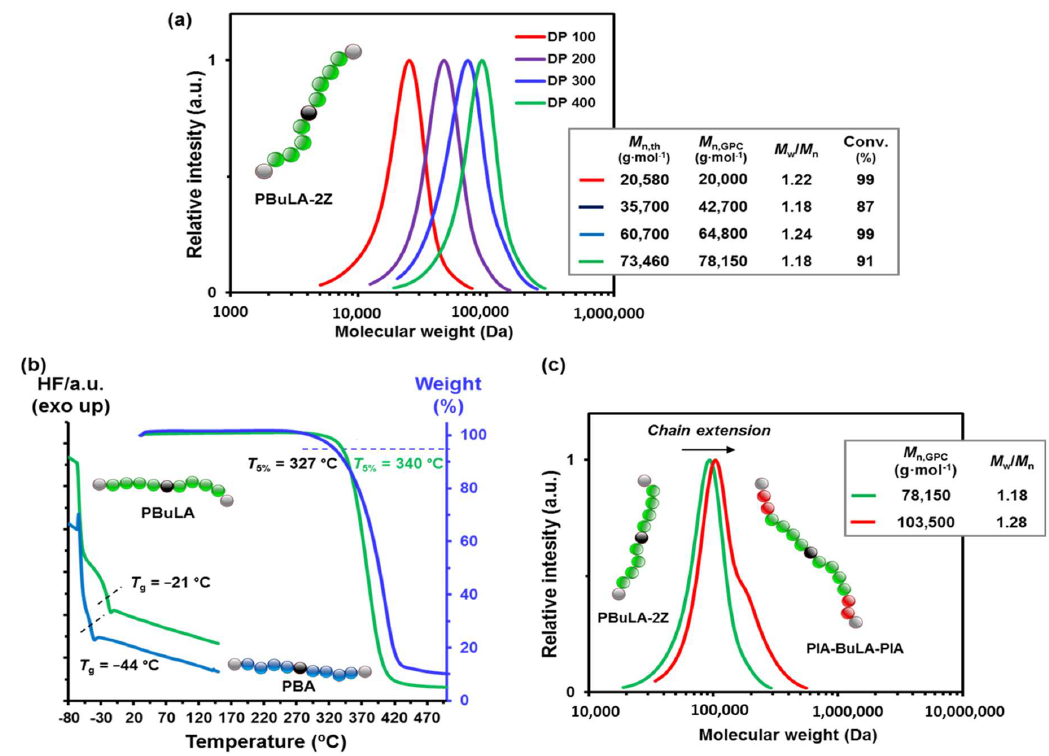
Figure 7. ( a ) Gel permeation chromatography (GPC) traces of PBuLA-2Z prepared at di ff erent DPs ranging from 50 to 400 by the bulk RAFT polymerization of BuLA with BTCBA at 70 ◦ C (The inset contains M n,th, M n,GPC, M w / M n , and monomer conversion values); ( b ) thermal characterization by di ff erential scanning calorimetry (DSC) and thermogravimetric analysis (TGA) analyses of PBuLA-2Z ( M n,GPC = 78,150 g · mol − 1 ) and PBA ( M n,GPC = 97,900 g · mol − 1 ); and ( c ) GPC traces of the chain extension of PBuLA-2Z macro-RAFT agent with IA monomer at 70 ◦ C in Rhodiasolv ® PolarClean solvent. The inset contains M n,GPC and M w / M n